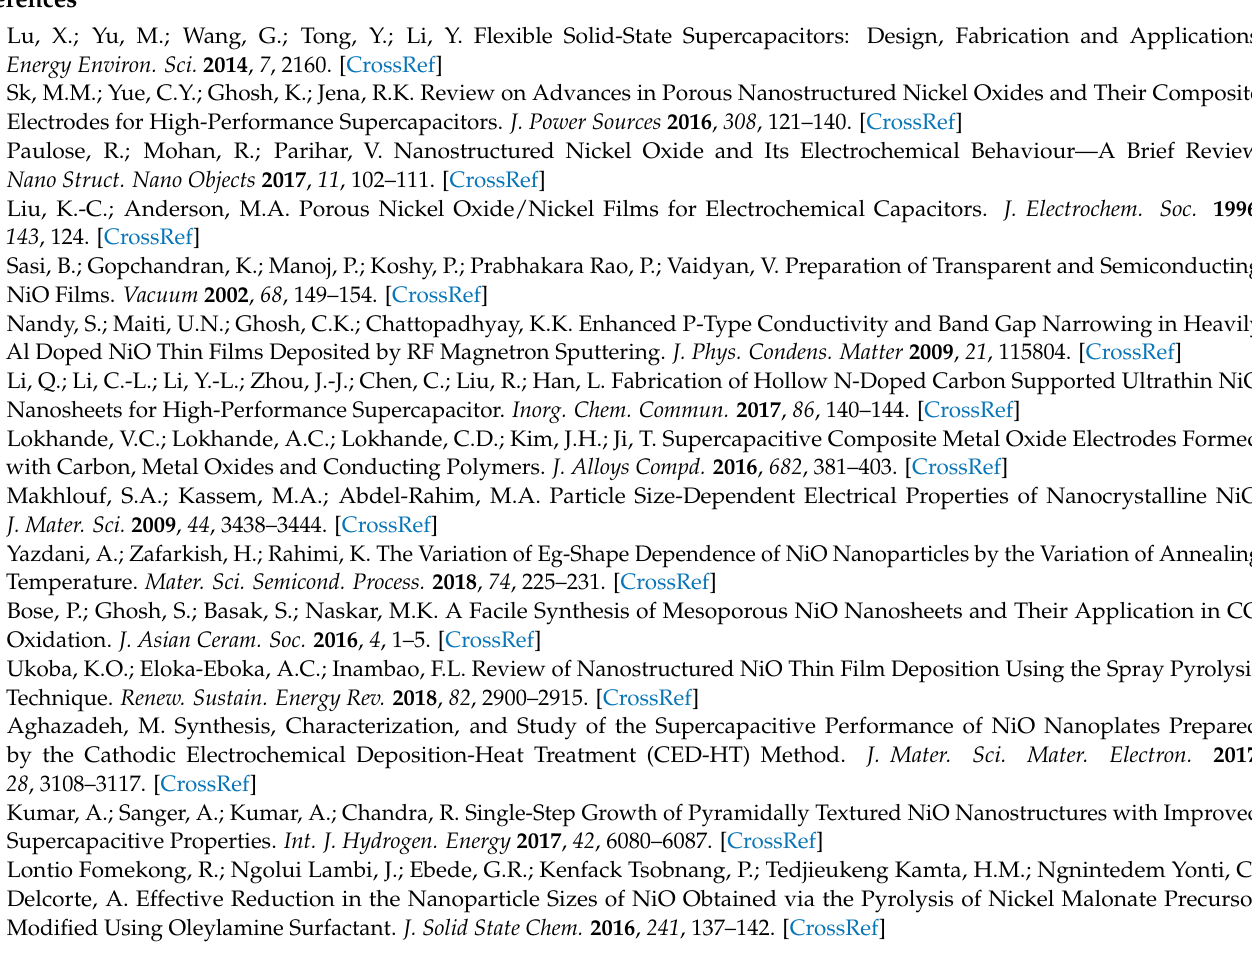
Figure S3: Decomposition into components of the NiO/Vulcan spectrum (NiO concentration—80%). Empty circles and blue curve correspond to experimental data, green curves—to NiO peaks, gray curves—to Vulcan peaks. Figure S4: The first group of NiO/Vulcan spectra. NiO concentrations: 10%, 20%, 30%, 50%, 80%. Figure S5: The second group of NiO/Vulcan spectra. NiO concentrations: 40%, 60%, 90%, 95%. Table S1: Comparison of electrochemical performances of NiO/C (60 wt%